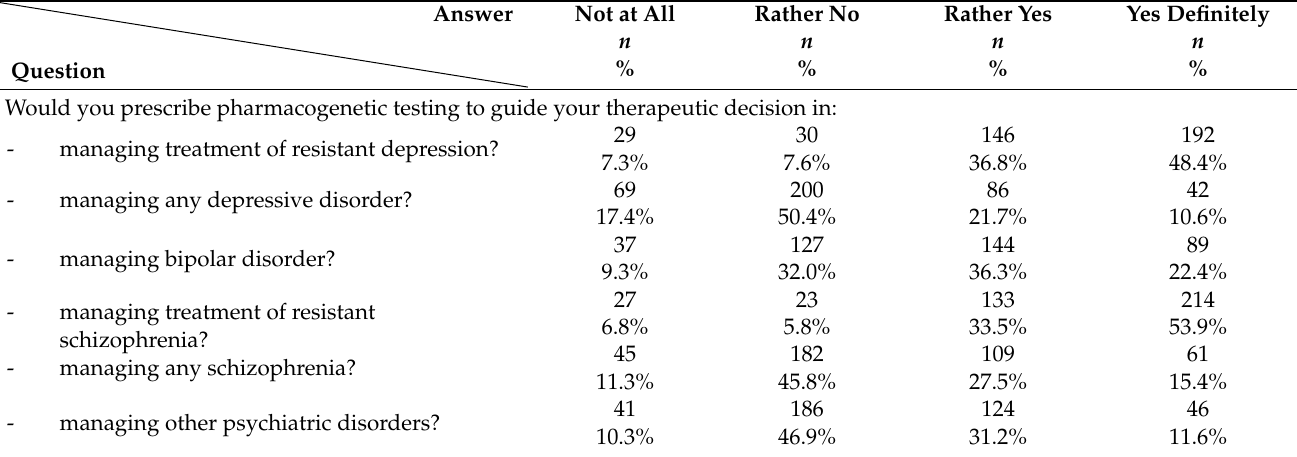
Table 2. Intent to use according to different psychiatric